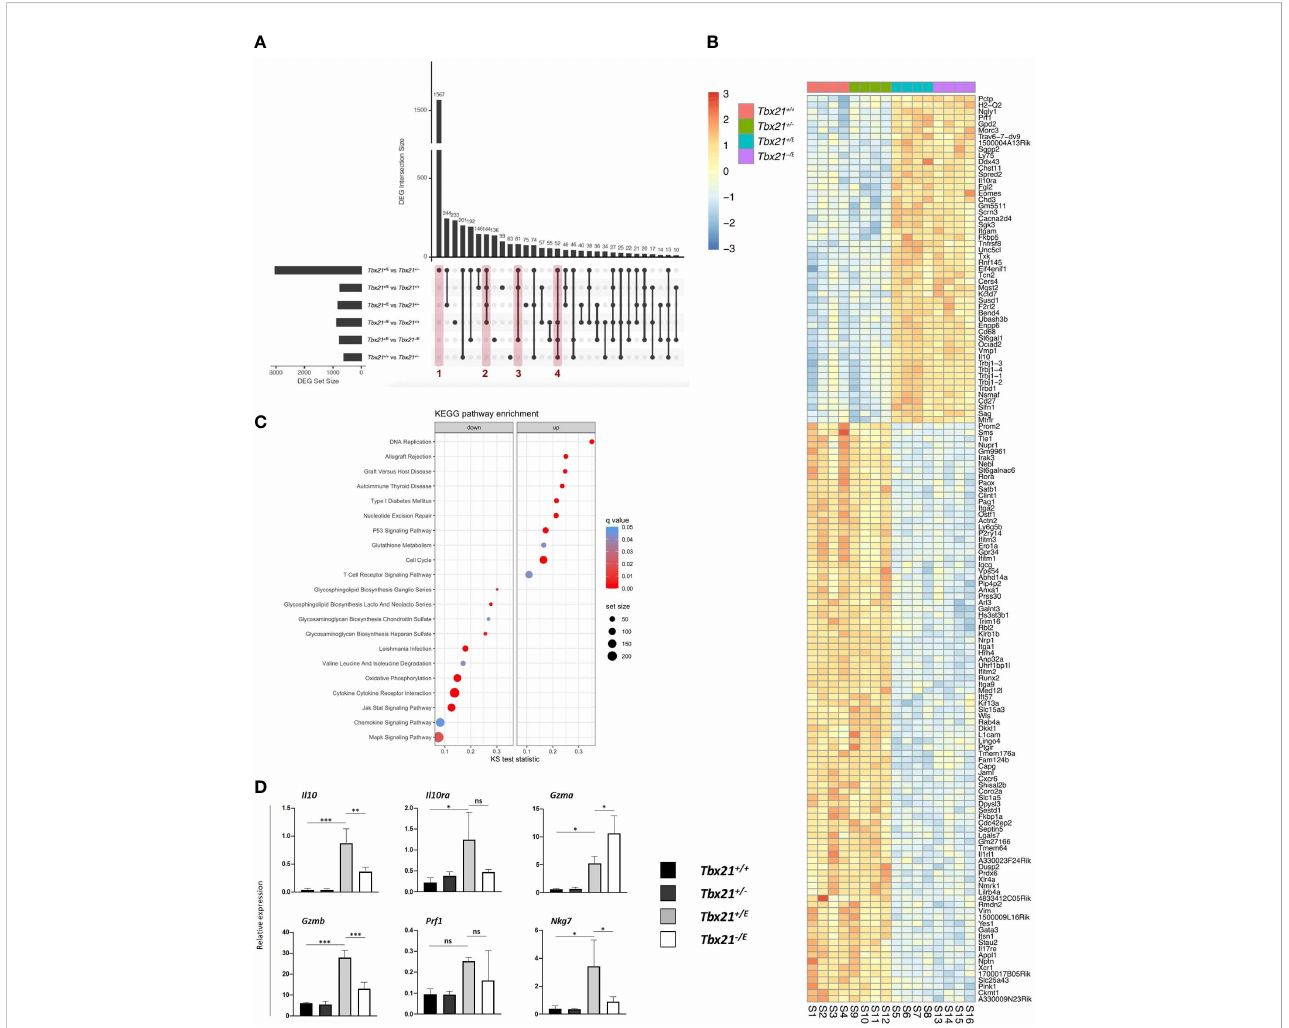
FIGURE 4 Transcriptional effects of Eomes in CD4 + T cells. SMARTA CD4 + T cells of the indicated genotypes were transferred into C57BL/6 mice, followed by LCMV infection as shown in Figure 2A. On day 8 after infection splenocytes were sorted, RNA isolated and sequencing performed. (A) Multi-comparison analysis of all genotypes shown in an upset plot. Set size de fi nes the total amount of differentially expressed genes (DEGs) in this comparison. Intersection size de fi nes the DEGs speci fi cally differentially expressed in the comparisons marked by dots and lines. Red columns mark comparisons further analyzed in (B/Suppl.). (B) Heatmap of DEGs marked by column 2 in Figure 4A ( Tbx21 +/E and Tbx21 -/E vs Tbx21 +/+ and Tbx21 +/- ) focussing on the role of Eomes in SMARTA CD4 + T cells. (C) KEGG pathway enrichment analysis. The x-axis shows the Kolmogorov-Smirnov (KS) test statistic for each pathway, the size of the dots represents the size of each pathway and the colour the statistical signi fi cance. (D) qPCR of selected targets (IL-10 pathway and cytotoxicity) to validate RNA-seq data from in vitro stimulated SMARTA CD4 + T cells. Statistical analysis: *=p < 0.05; **=p < 0.01; ***=p < 0.001; ns, not signi fi cant; Error bars denote mean +